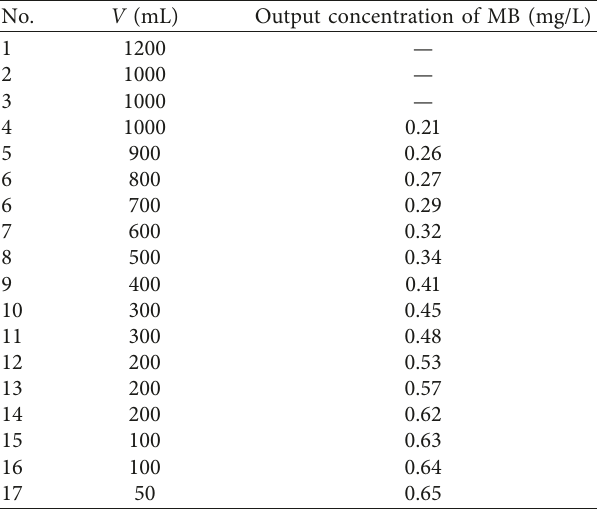
Table 3: Results of the large-scale surveys on the heterogeneous Fenton catalytic oxidation performance of M2.